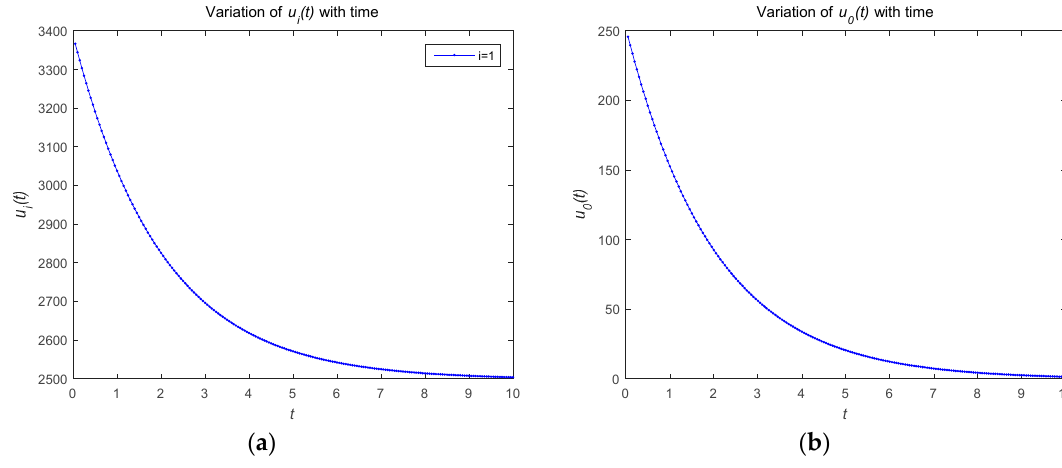
Figure 1. ( a ) Optimal strategy of the attackers; ( b ) optimal strategy of the defender.